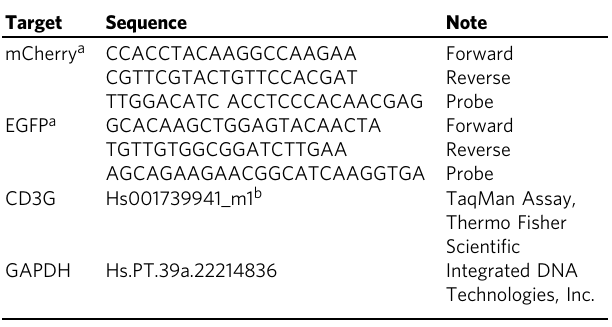
Table 1 List of primers used for